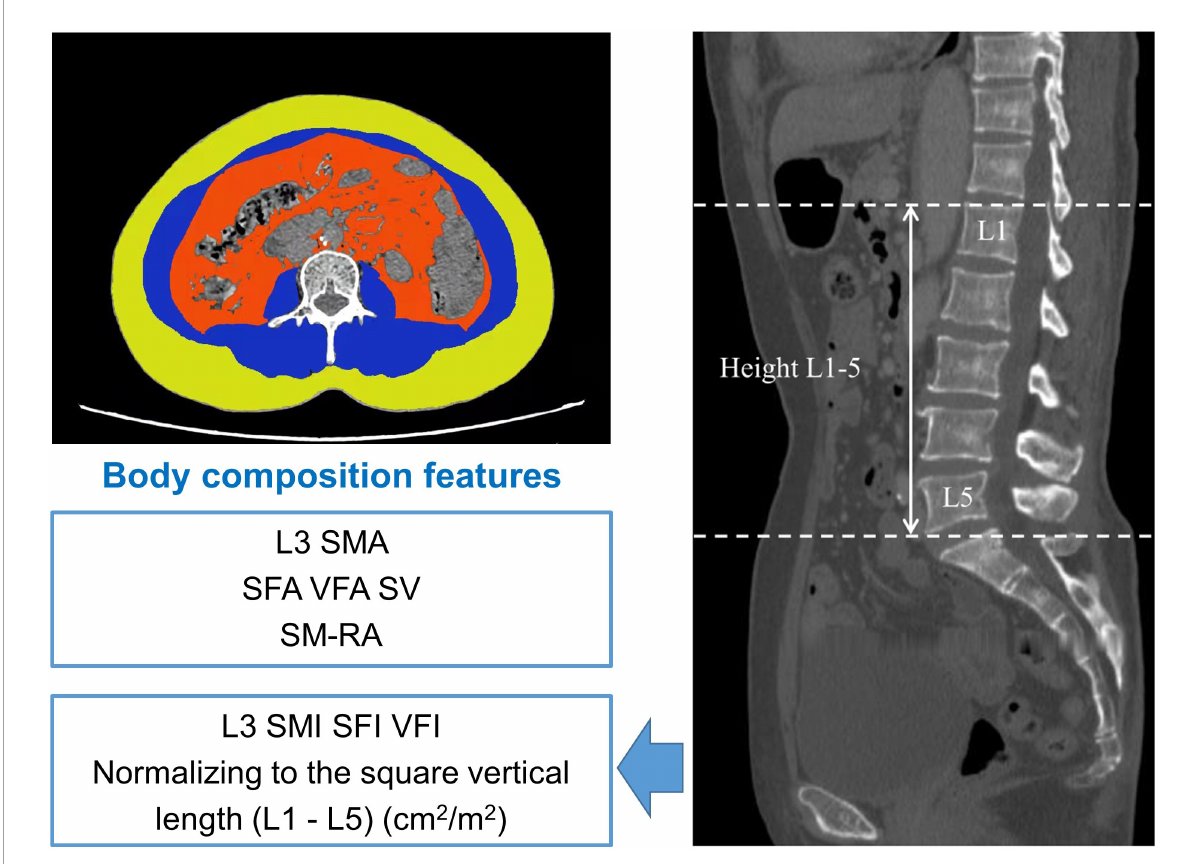
FIGURE1 Body composition measurement of the third lumbar vertebra region. Yellow region: subcutaneous fat area (SFA) (cm 2 ); blue region: L3 lumbar skeletal muscle area (L3 SMA) (cm 2 ), red region: visceral fat area (VFA) (cm 2 ). SFI, subcutaneous fat index; SM-RA, skeletal muscle radiation attenuation; SV, subcutaneous and visceral ratio; L3 SMI, L3 skeletal muscle index; VFI, visceral fat